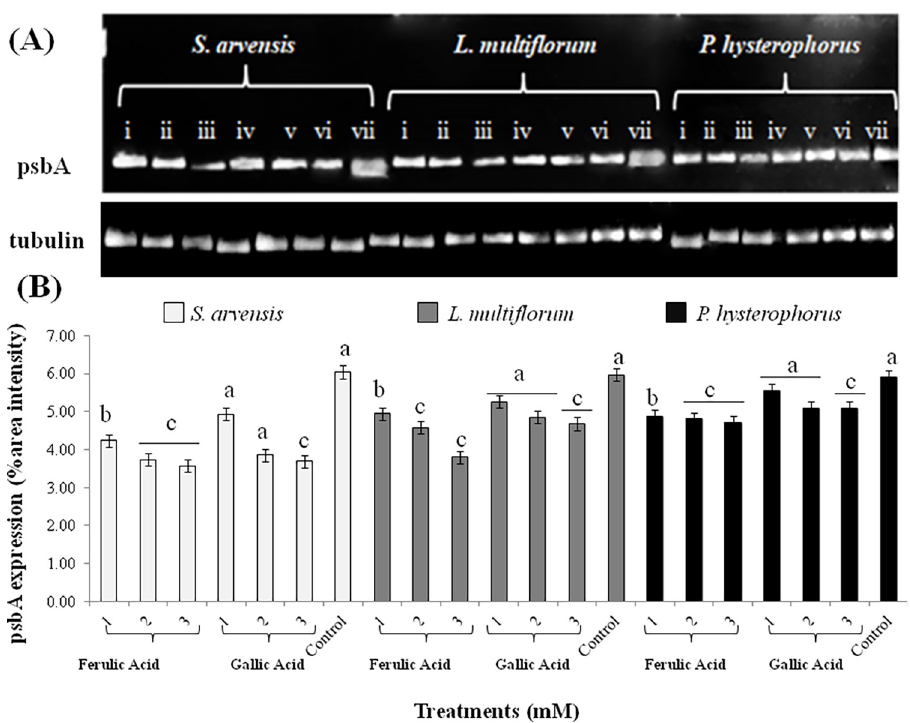
Fig 5. Expression levels of psbA gene in weeds treated with different concentrations of ferulic acid (FA) and gallic acid (GA) as expressed with semi-quantitative PCR analysis. (A) Downregulated transcription levels of psbA in Sinapis arvensis , Lolium multiflorum and Parthenium hysterophorus after 48 h of FA and GA treatment application in comparison to aqueous control. For each weed; (i) 1mM FA; (ii) 2mM FA; (iii) 3mM FA; (iv) 1mM GA; (v) 2mM GA; (vi) 3mM GA; (vii) aqueous control. (B) Relative expression of psbA gene in treated and control weed samples as depicted with relative percentage area intensity of bands. Values are presented as mean ± SE (n = 3). Bar values with different letters differ significantly from each other at P <